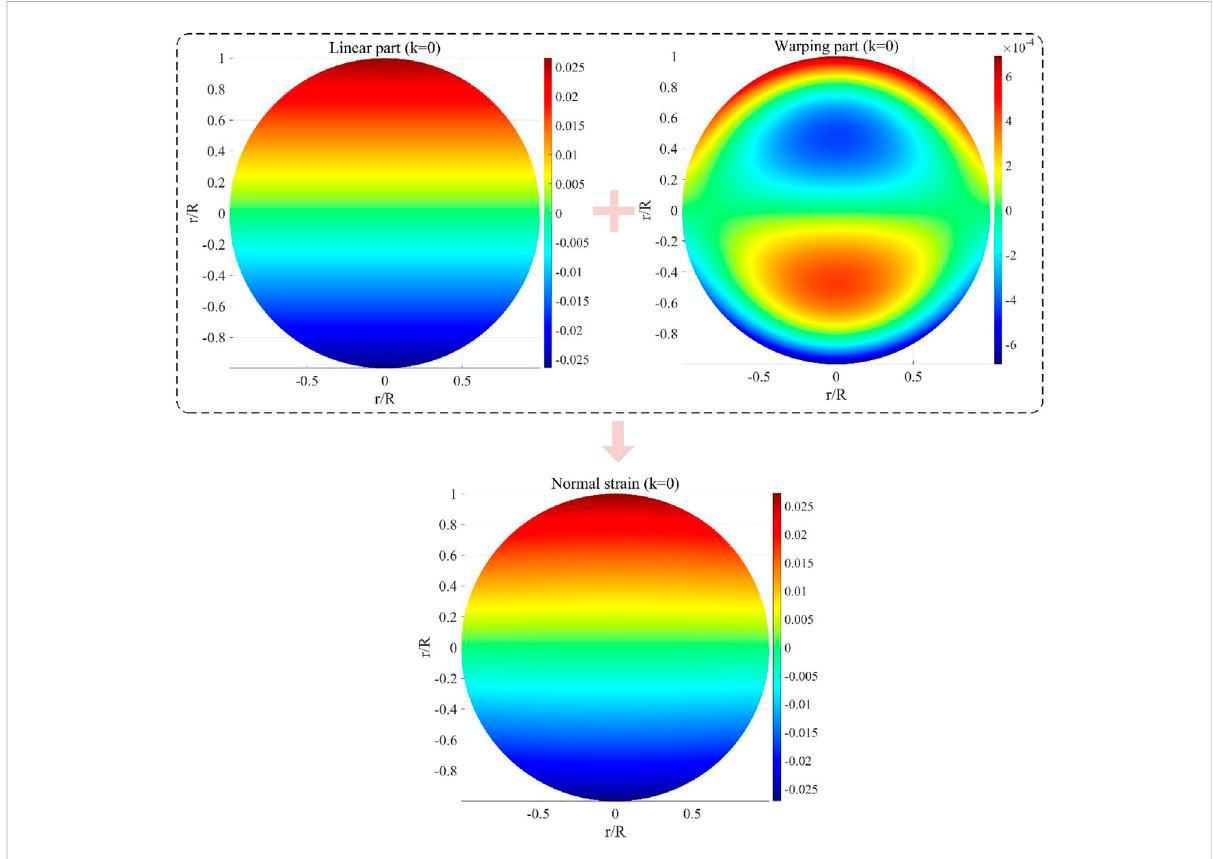
FIGURE 4 The normal strain and its decomposition for k =